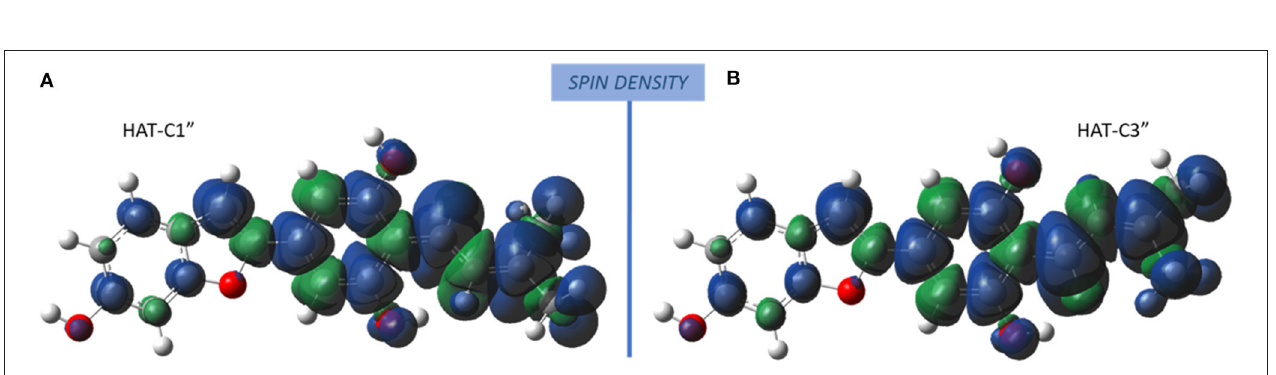
FIGURE 4 | Spin density distribution in the radical obtained after the HAT process at C1 ′′ (moracin) and C3 ′′ ( iso -moracin) sites. (A) Moracin C. (B) Iso-moracin C.